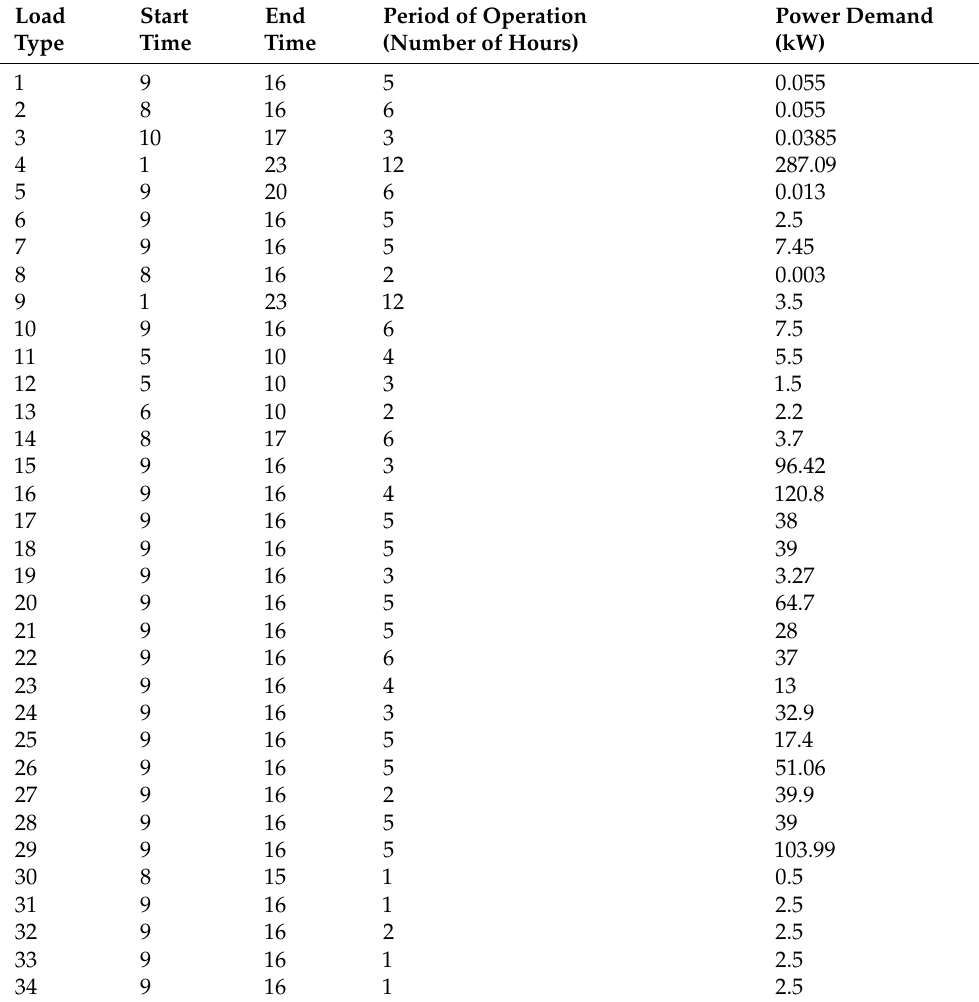
Table 5. Power ratings and period of operation of the load